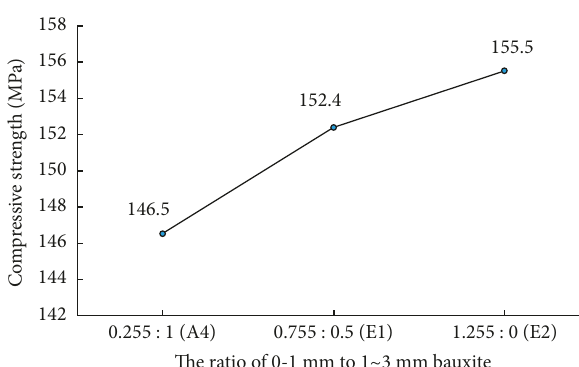
Figure 11: Influence of the amount of different particle sizes of sintered bauxite on the compressive strength of